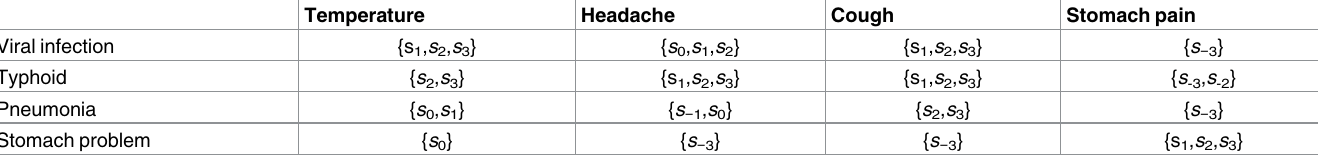
Table 1. Symptoms characteristic for the considered diagnosis in terms of HFLTSs.